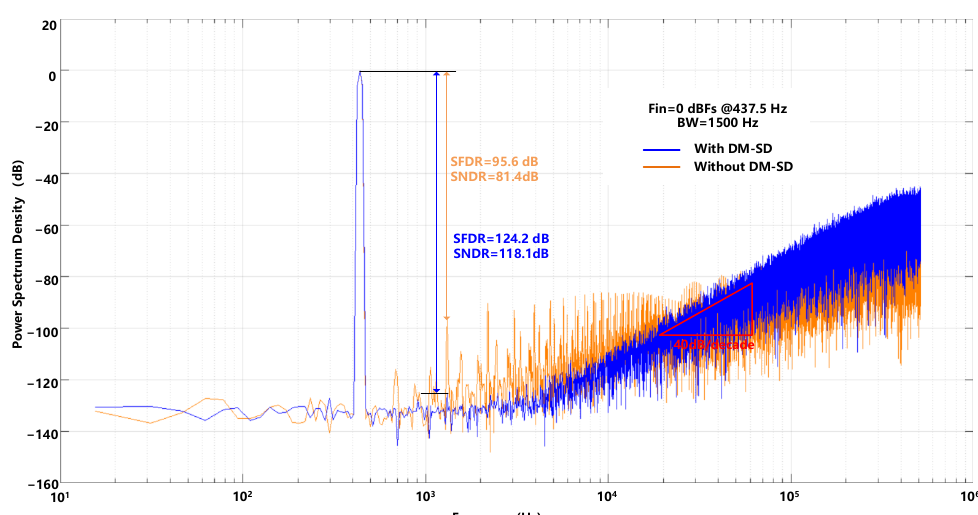
Figure 18. The power spectrum of the proposed modulator simulated with transient noise.